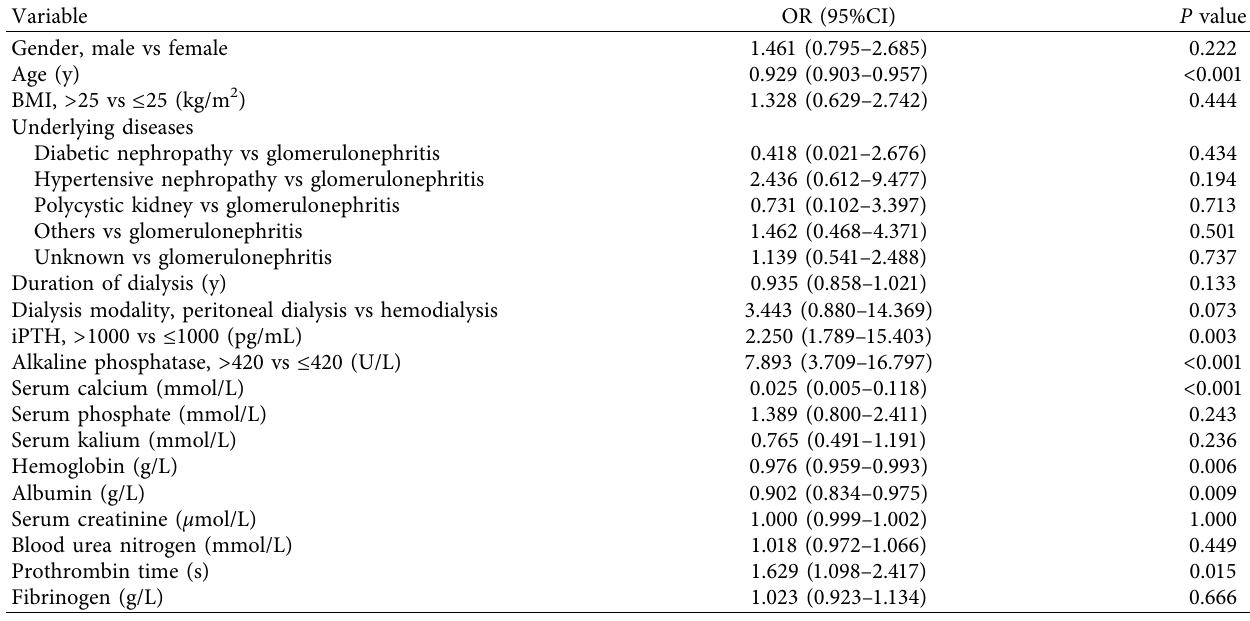
Table 2: Univariate logistic regression analysis of SH presence based on preoperative data in the training cohort.